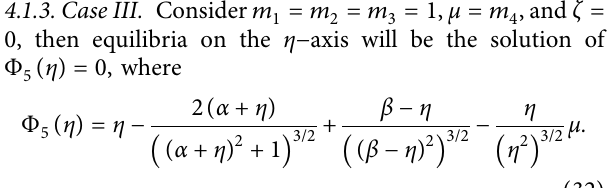
Figure 15: Case III ( m (b) equilibrium solutions on ζ − axis. Te blue curve corresponds to the solutions of Φ